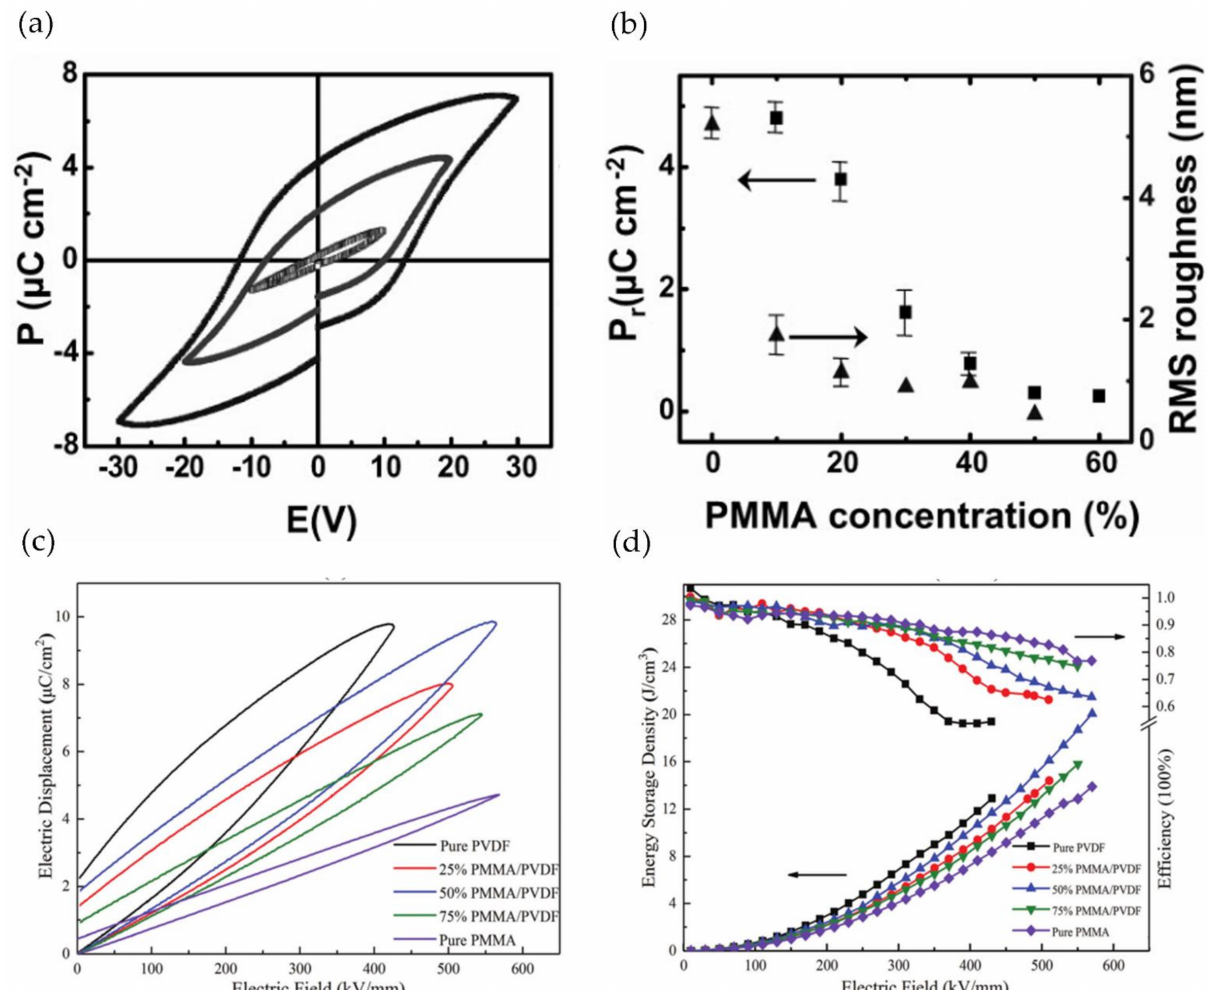
Figure 12. ( a ) The P-E loops of PMMA/PVDF (20:80) film ice-quenched and subsequently annealed at 150 ◦ C; ( b ) Plots of P r and RMS roughness as a function of the amount of the PMMA content. Reprinted with permission from [122]. Copyright (2009), Wiley. The electrical performances of PMMA/PVDF blended films with different content at 150 ◦ C heat treatment ( c ) ferroelectric properties; ( d ) energy storage performances. Reprinted with permission from [124]. Copyright (2019), Royal Society of